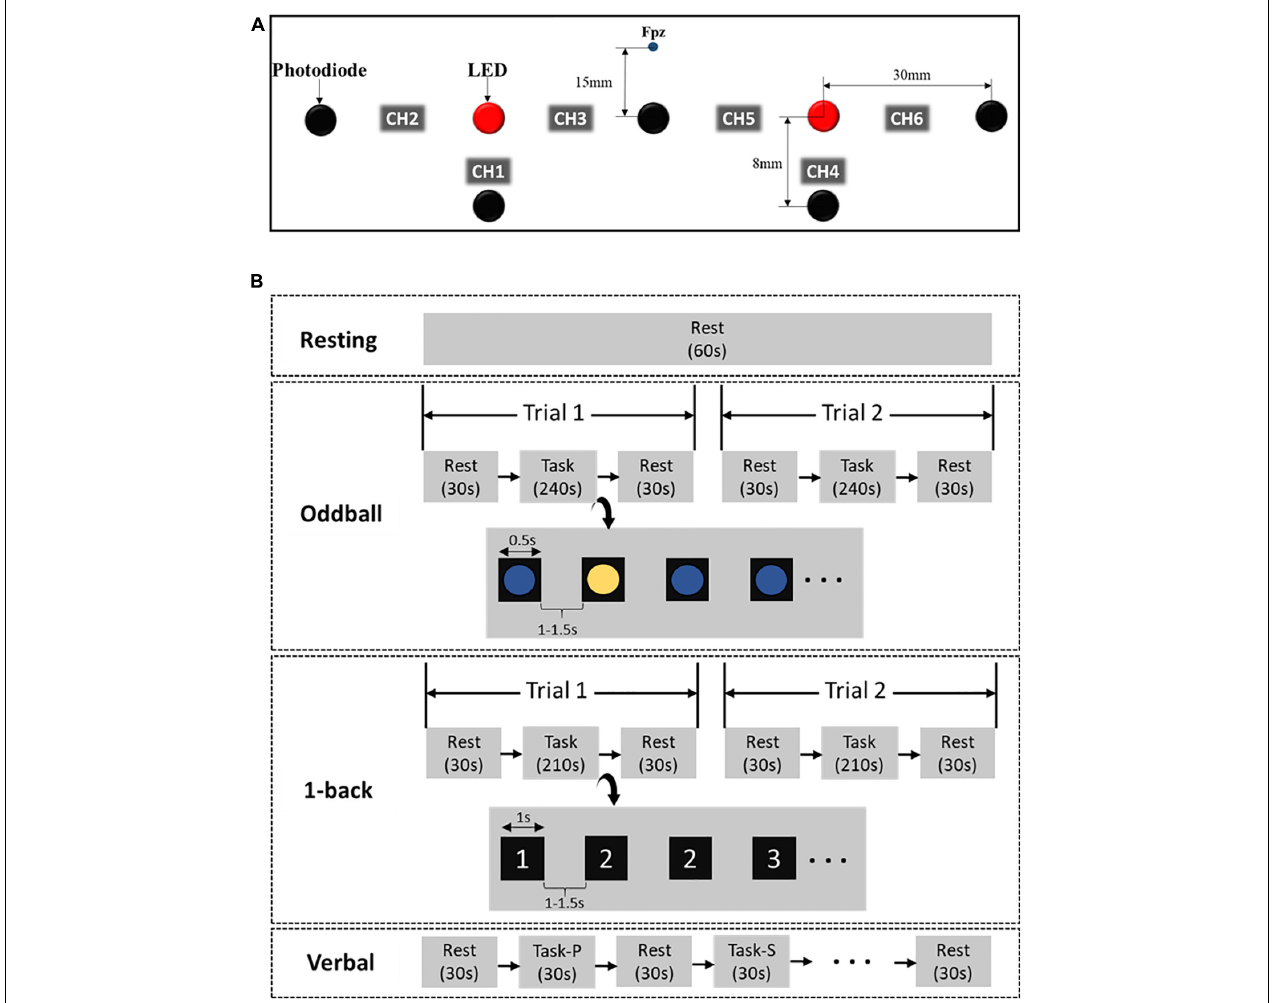
FIGURE 1 | fNIRS device setup (A) and experimental protocol (B) (s, second; P, phonemic; S,